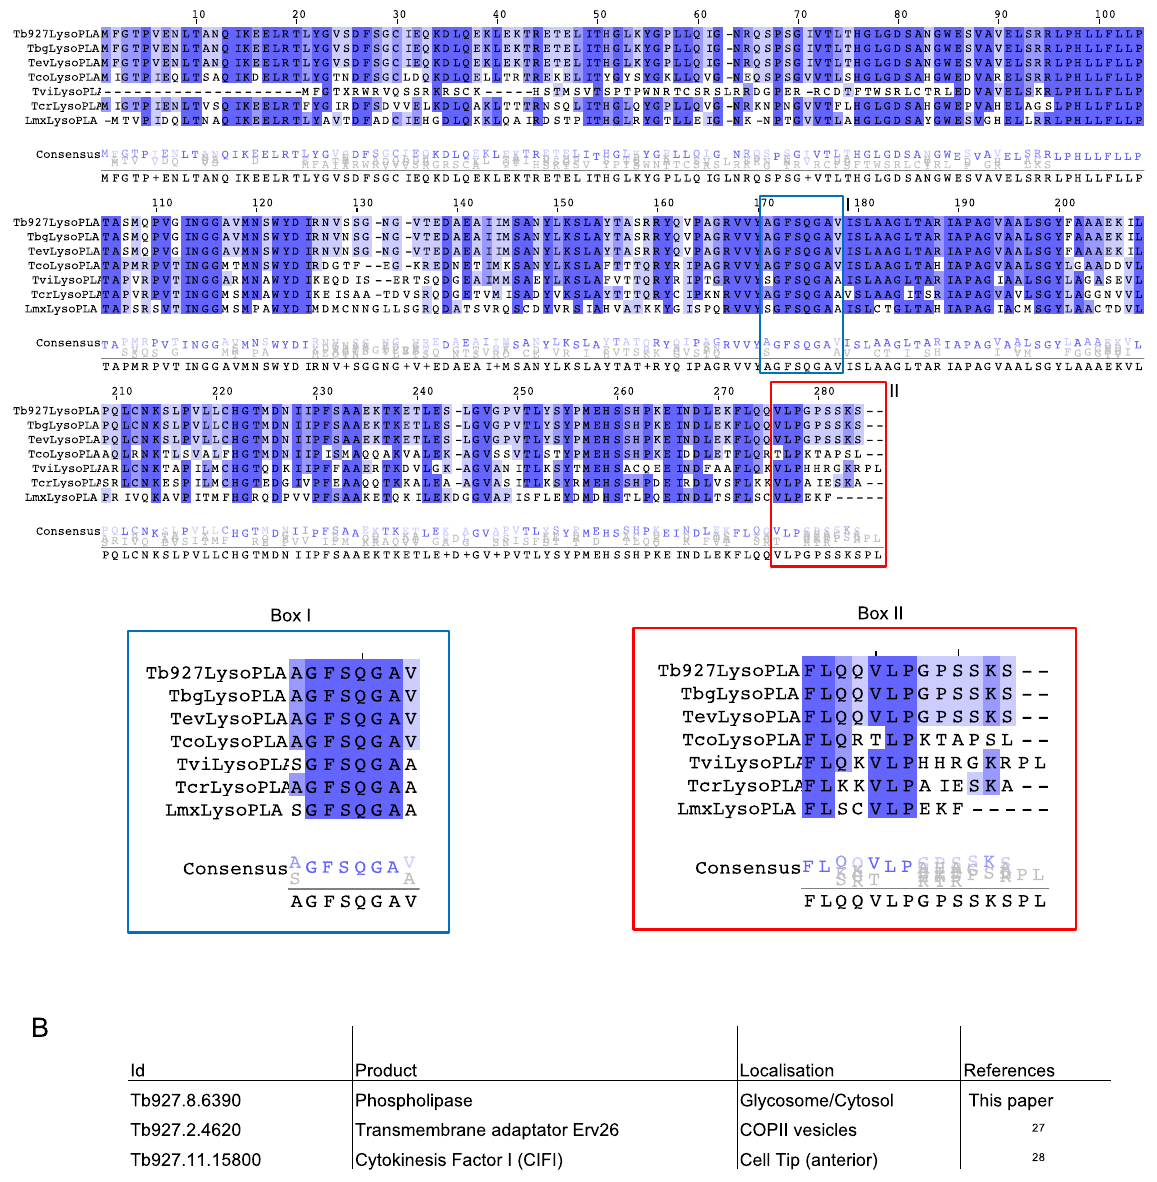
Figure 1. Comparison of LysoPLA in kinetoplastids. ( A ) Alignment of LysoPLA from kinetoplastids. Sequences were extracted and aligned using Clustal omega. Dark blue contains conserved residues, white to light blue contains conservative changes. Box I emphasizes the conservation of the putative phospholipase active site. Box II emphasizes the differences between kinetoplastids LysoPLA Carboxy-terminus. Tb, Trypanosoma brucei brucei (Tb927.8.6390) ; Tbg, Trypanosoma brucei gambiense (Tbg972.8.6450) , Tev, Trypanosoma evansi (TevSTIB805.5.6680); Tco, Trypanosoma congolense (TcIL3000_8_6240) ; Tv, Trypanosoma vivax (TvY486_0805980) ; Tcr, Trypanosoma cruzi (TcCLB.506797.70) ; Lmx, Leishmania Mexicana (LmxM.24.1840) . ( B ) Only 3 proteins are ending with SKS in Trypanosoma brucei brucei. The search was performed on TriTrypDB.org using the « Protein Motif Pattern »